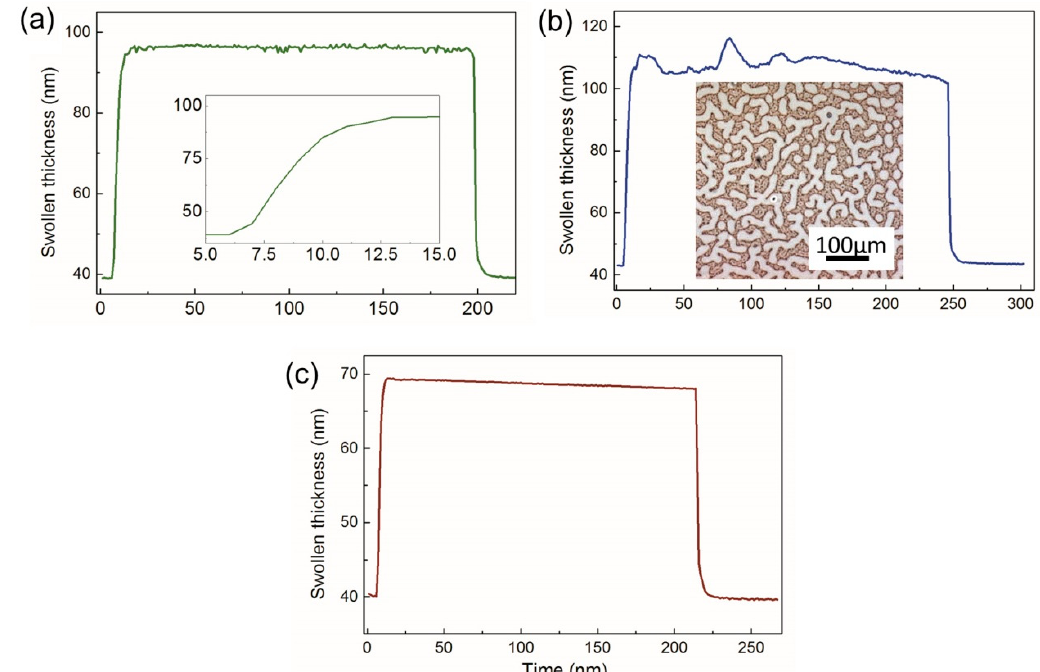
Figure 2. ( a – c ) Examples of the swelling curves during continuous annealing process. Thickness of swollen films was monitored by in situ ellipsometry. Inset in ( a ) illustrates the initial fast regime of the solvent uptake. Inset in ( b ) is an optical image of Polystyrene- b -poly(2-vinyl pyridine) (PS-PVP) film showing characteristic terracing upon condensation of the solvent on the film surface in the course of annealing.